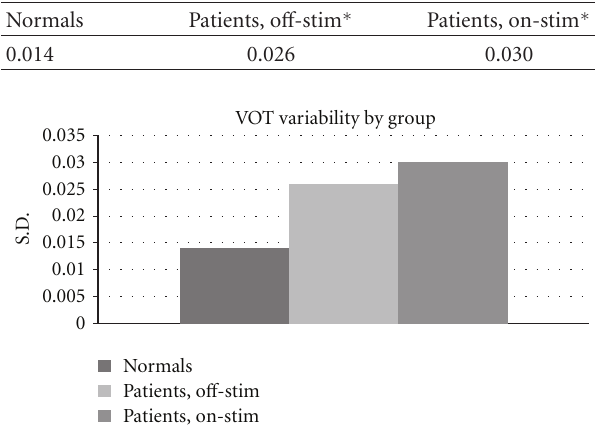
Table 6: VOT variability (S.D.) by group. ( ∗ = di ff erence from normal significant at P ≤ . 01).